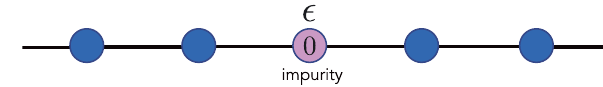
Figure 2: Impurity problem. A local static potential is added to the photonic bath, which is equivalent to a detuning 𝜖 changing the frequency of cavity 0 as 𝜔